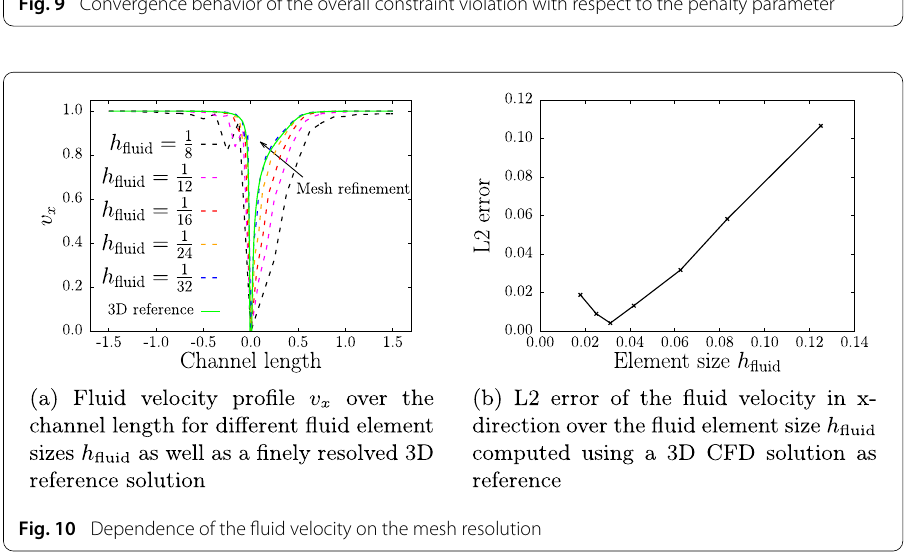
Fig. 9 Convergence behavior of the overall constraint violation with respect to the penalty parameter